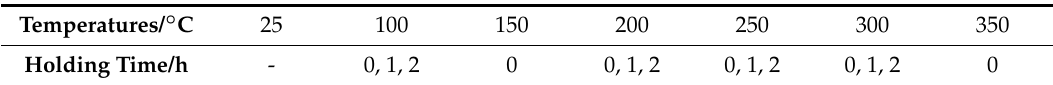
Table 2. Designation of tested